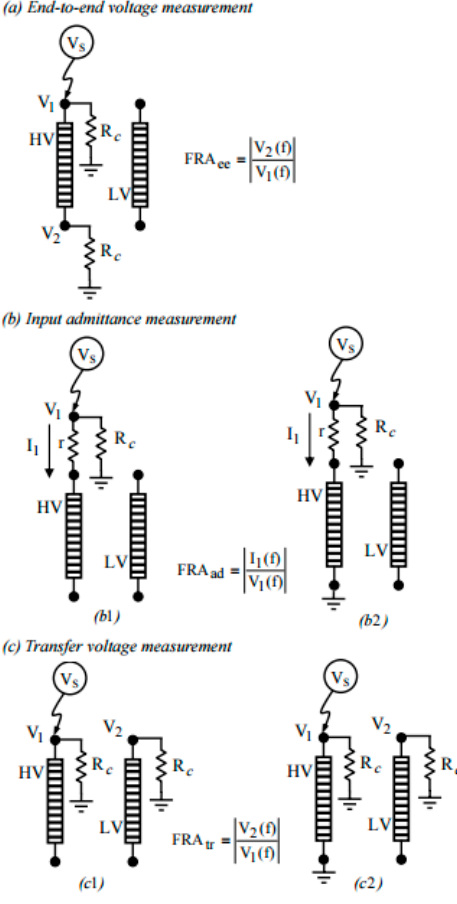
Figure 7. Test correction for FRA Measurements [20].